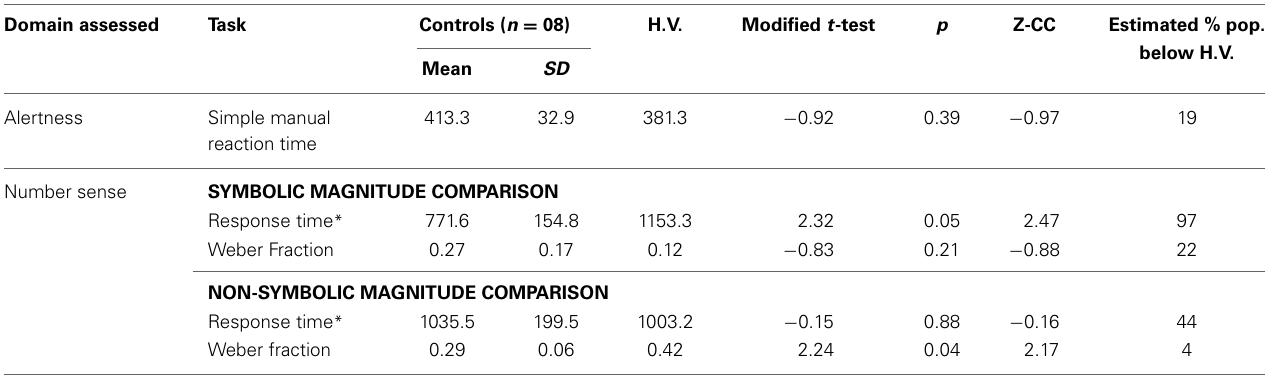
Table 2 | Descriptive data and comparison between the control groups and H.V., in the alertness and number sense tasks. Domain assessed